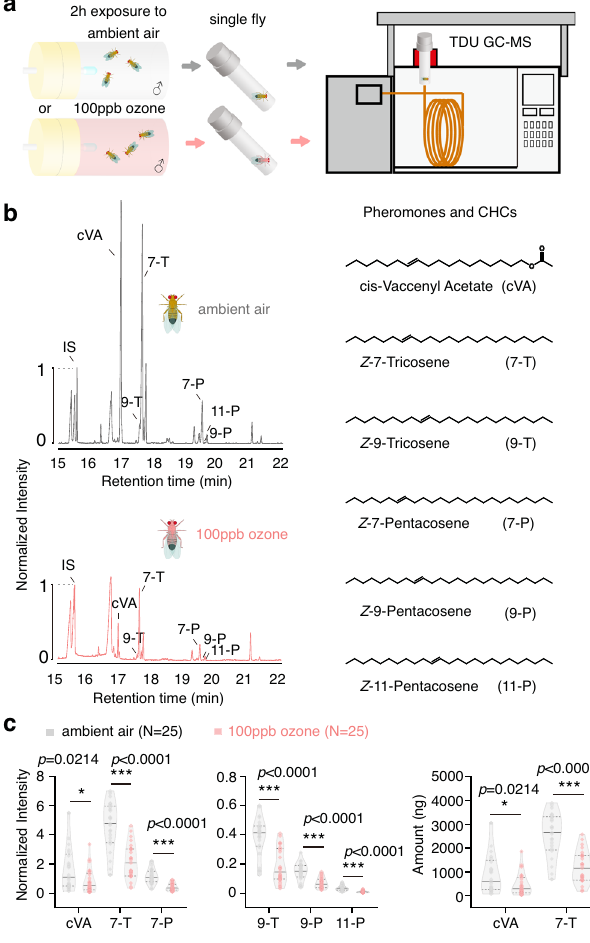
Fig. 1 | TDU GC-MS analysis of D. melanogaster (CS) male pheromones and cuticular hydrocarbons. a Schematic drawing of the TDU GC-MS analytical pro- tocol. Male fl ies were fi rst exposed to ozone or ambient air. Their chemical pro fi le was then analyzed by TDU GC-MS. b Chemical pro fi les of D. melanogaster males after exposure to ozone (pink) or ambient air (grey). Chromatograms (left panel), Chemicalstructures of male pheromones and cuticularhydrocarbons, CHCs (right panel). c , Quantitative analysis of male pheromones and CHCs. (Two-tailed unpaired t -test; * p <0.05; ** p <0.01; *** p <0.001). Source data are provided as a Source Data fi